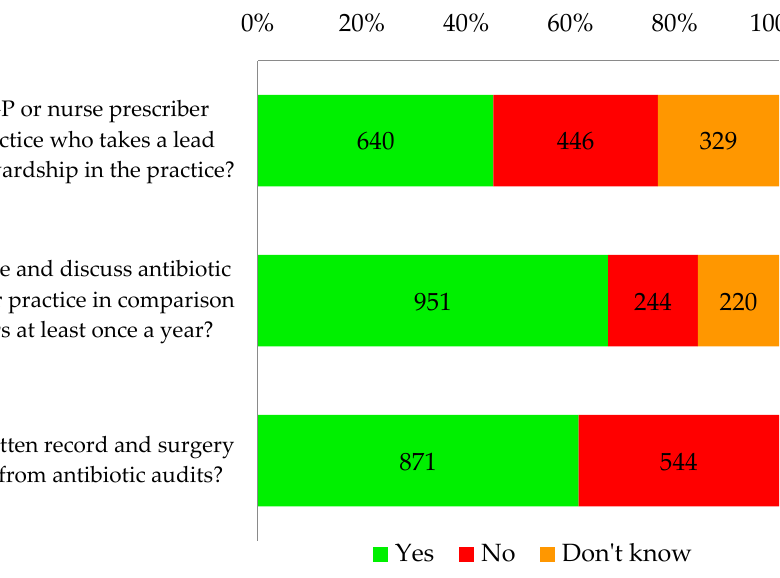
Figure 4. What most practices should aim to do soon.